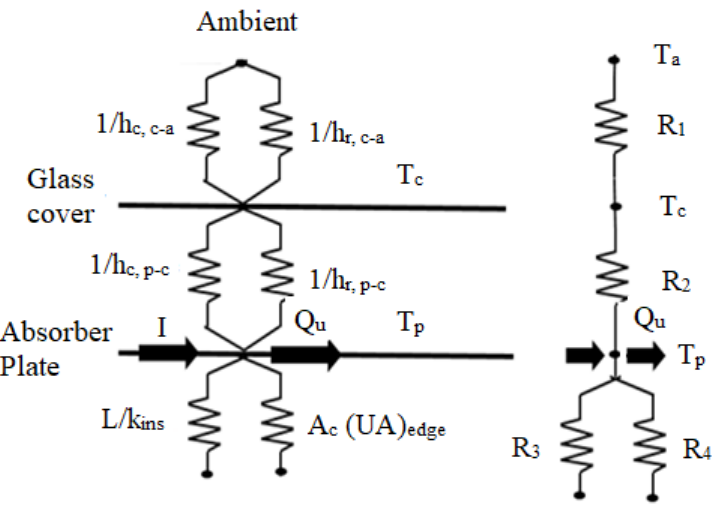
Figure 2. Thermal resistance in SAH on the basis of convection and radiation coefficient.